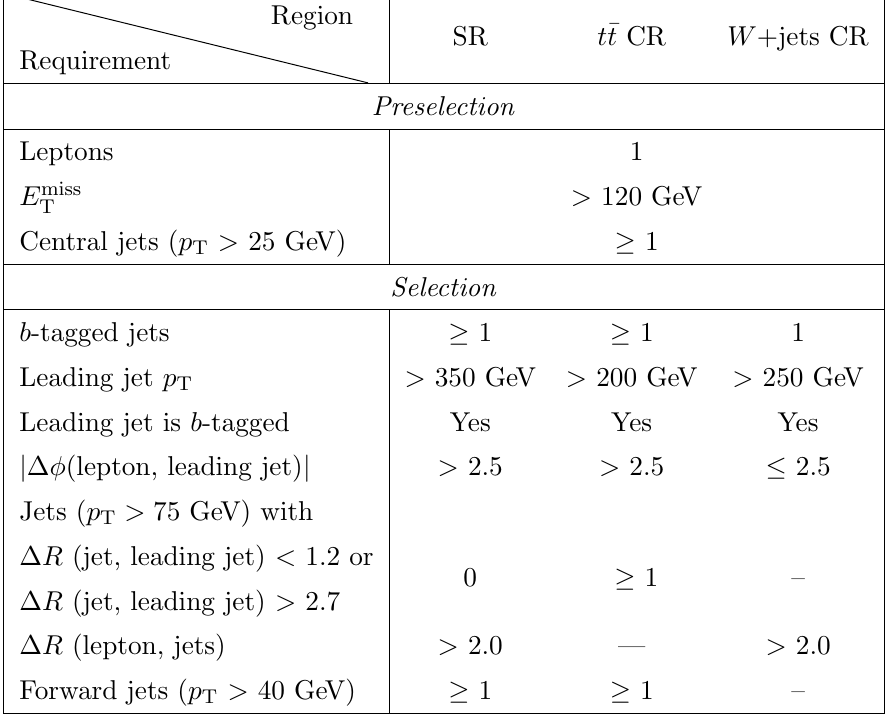
Table 2. Summary of common preselection requirements and selection requirements for the SR compared to those for the t (cid:22) t and W +jets CRs. All other selection requirements are the same for all three